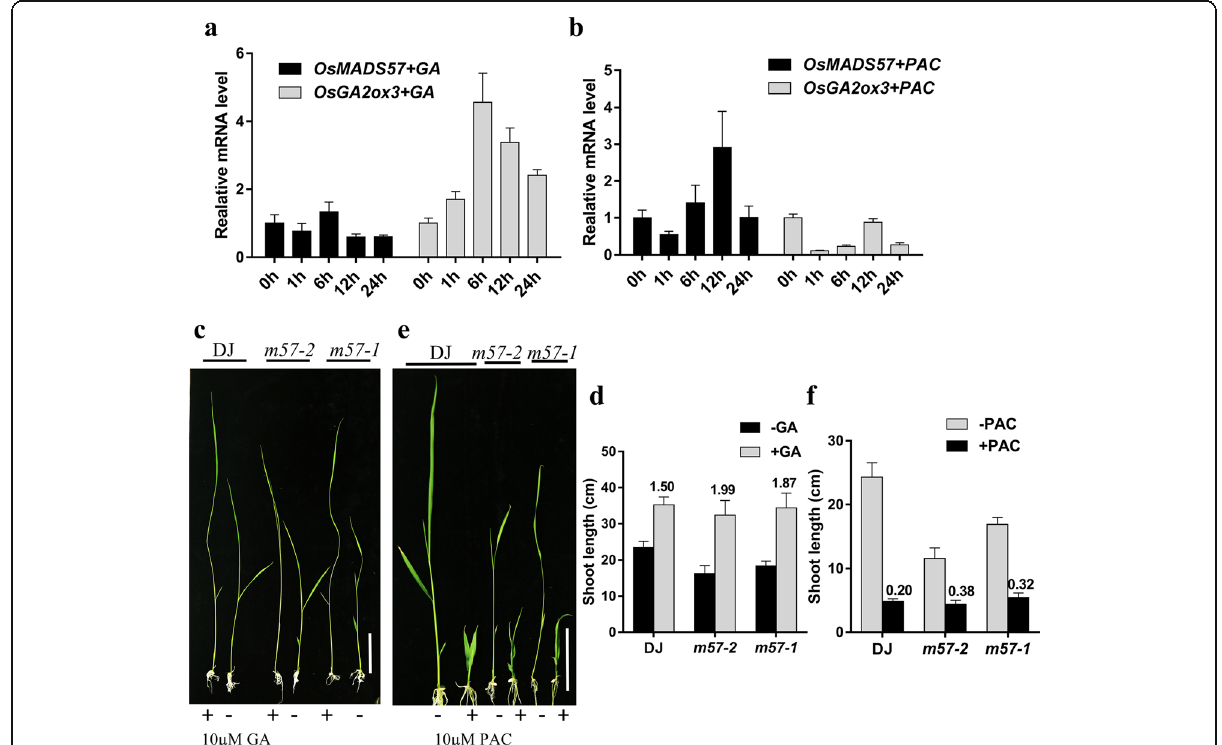
Fig. 3 Response of m57 – 2 and m57 – 1 mutants to GA and PAC. a and b 50 μ М GA 3 ( a ) or 10 μ М paclobutrazol ( b ) treatment suppressed and enhanced the expression of OsMADS57 , respectively. OsGA2ox3 was used as a positive control. c Semi-dwarf phenotype of m57 – 2 and m57 – 1 mutants can be rescued by GA 3 . The mutants were treated with exogenous 10 μ М GA 3 for 10 d. Bars = 5 cm. d Shoot length of seedlings before and after 10 μ М GA 3 treatment for 10 d. e Seedling morphology of mutants and wild-type plants grown with or without 10 μ М PAC for 10 d. Bars = 5 cm. f Shoot length of seedlings before and after 10 μ М PAC treatment for 10 d. Numbers above the bars indicate the elongation ratio of seedlings after treatment (the shoot length after treatment divided by the shoot length before treatment). DJ, wild type; m57 – 2 , osmads57 – 2 ; m57 – 1 , osmads57 – 1 . Three independent experiments were conducted with similar results. The data are means± SD ( n = 15). Error bars indicate